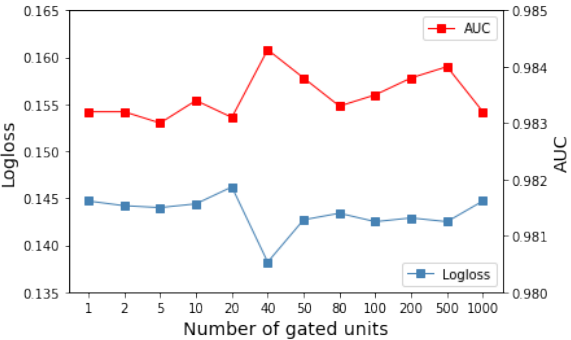
Figure 6. Effects of number of gated units on model